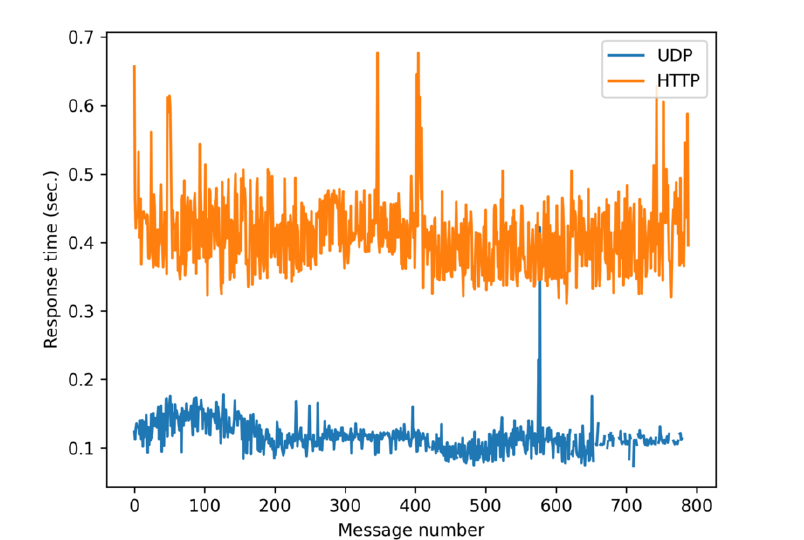
Figure 4. Response time of a trip by bike (20 km/h) comparing the response time with the two versions of the SafeCyclists